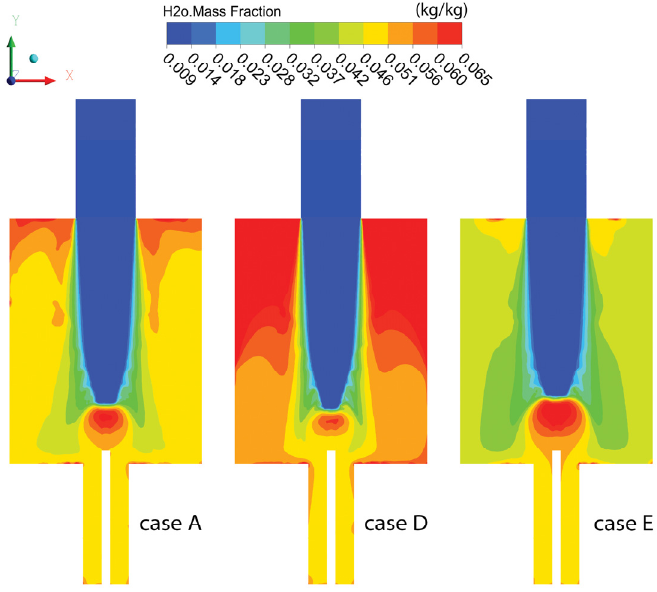
Figure 11. Gas moisture fraction profile across the central axial cross-sectional plane (XY) for three different initial spray SMD, Case A = 48 µ m; Case D = 58 µ m; Case E = 38 µ m (to provide better clarity of different moisture fractions in the dryer, the maximum value has been restricted to 0.065). Table 5. Particle mean diameter and mean residence time at outlet .